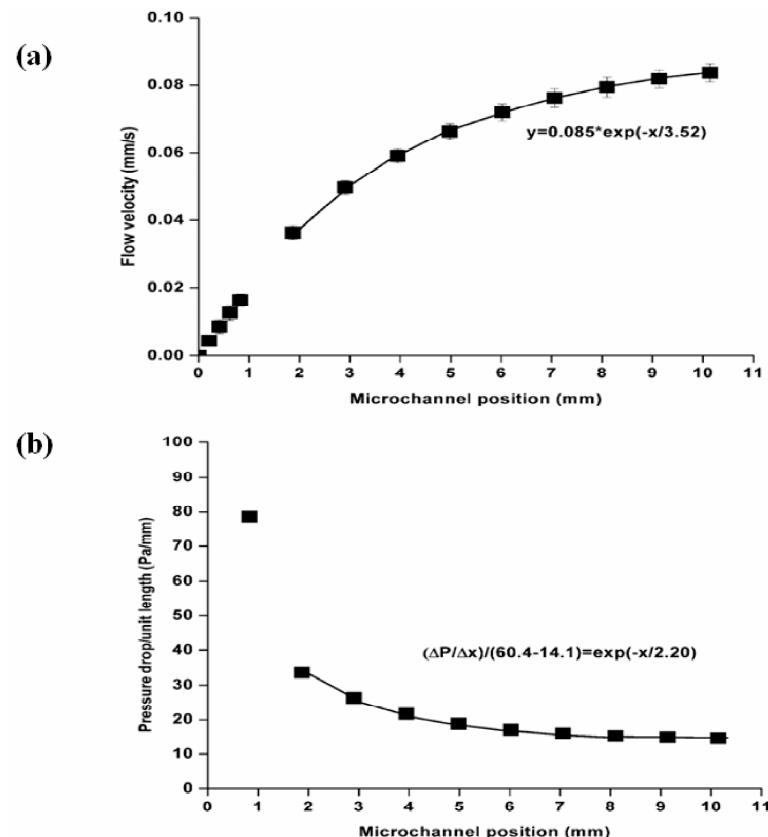
Figure 3. Typical derived data and curve fits for shallow microchannels with an obstacle FS2 at a flow rate of 1.0 µL/min ( a ) meniscus velocity and ( b ) inlet pressure. Table 2. Analysis of the first-order response for flow velocity and pressure drop/unit length.